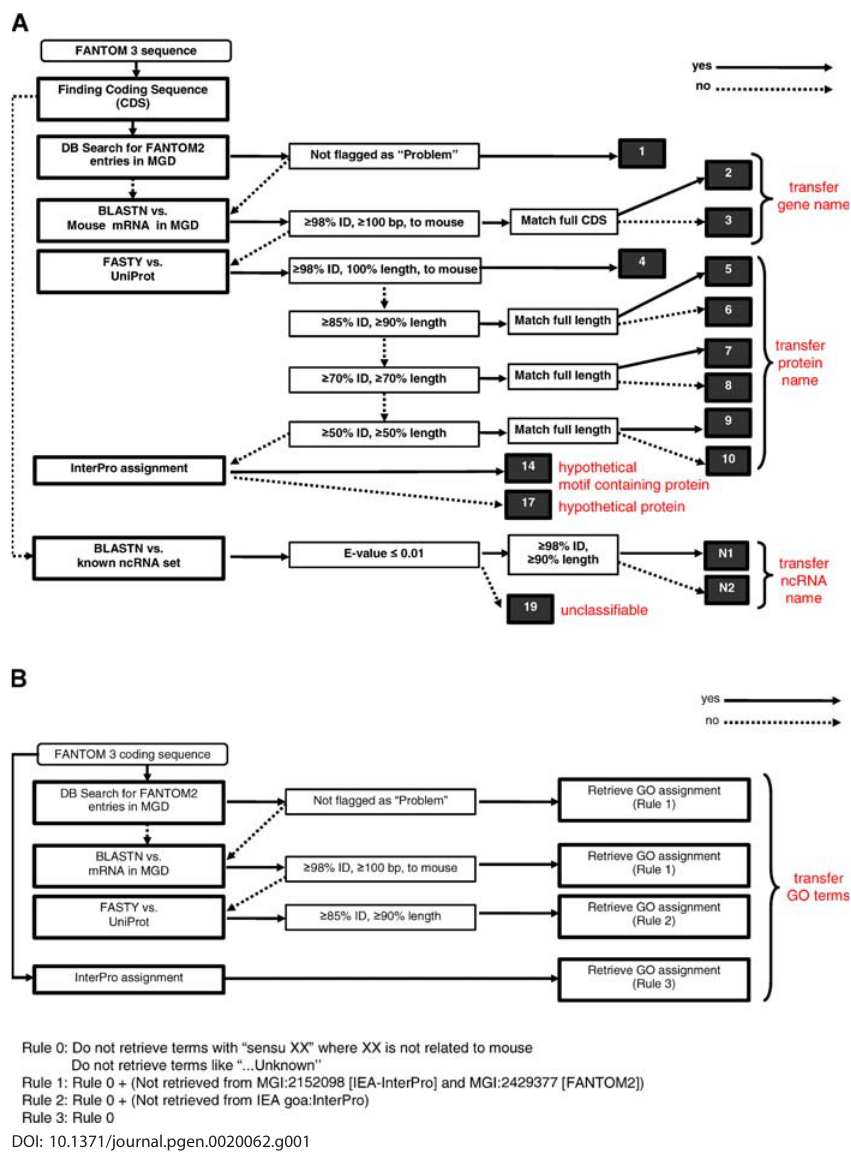
Figure 1. Annotation Pipelines for Transcript Description and for GO Terms (A) Pipeline for transcript description. Query sequences falling into categories (black boxes) 1–3 were assigned the description of the matched target sequence DNA entry in MGI symbols, and synonyms were also transferred to our annotation database. Queries falling into categories 4–10 were assigned a transcript description corresponding to the matched protein name. For query sequences falling into category 5 or 6, the keyword ‘‘ homolog ’’ was appended to the matching protein name. Sequences assigned to category 7 or 8 were denoted with the prefix ‘‘ similar to ’’ attached to the target sequence name. The prefix ‘‘ weakly similar ’’ was used to identify sequences assigned to category 9 or 10. For all sequences in categories 5– 10, the name of the organism corresponding to the matched protein was appended to the assigned transcript description. If a query was assigned to category 14, its transcript description was ‘‘ hypothetical [InterPro domain name] containing protein. ’’ Query sequences assigned to category 17 and 19 were annotated as ‘‘ hypothetical protein ’’ and ‘‘ unclassifiable, ’’ respectively. Query sequences grouped into category N1 or N2 were assigned the description of the matched target ncRNA entry. For query sequences falling into category N2, the keyword ‘‘ homolog of ’’ was appended to the matching ncRNA name. (B) Pipeline for GO terms. DB,